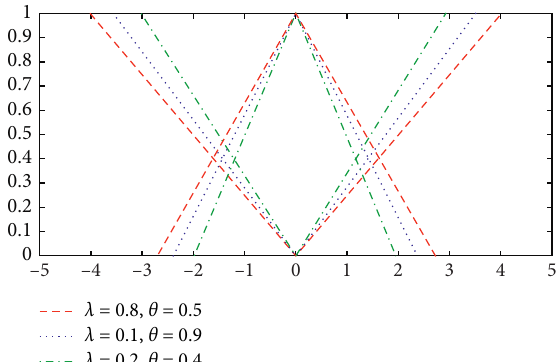
Figure 2: The curve of intuitionistic fuzzy solutions 〈 ϕ